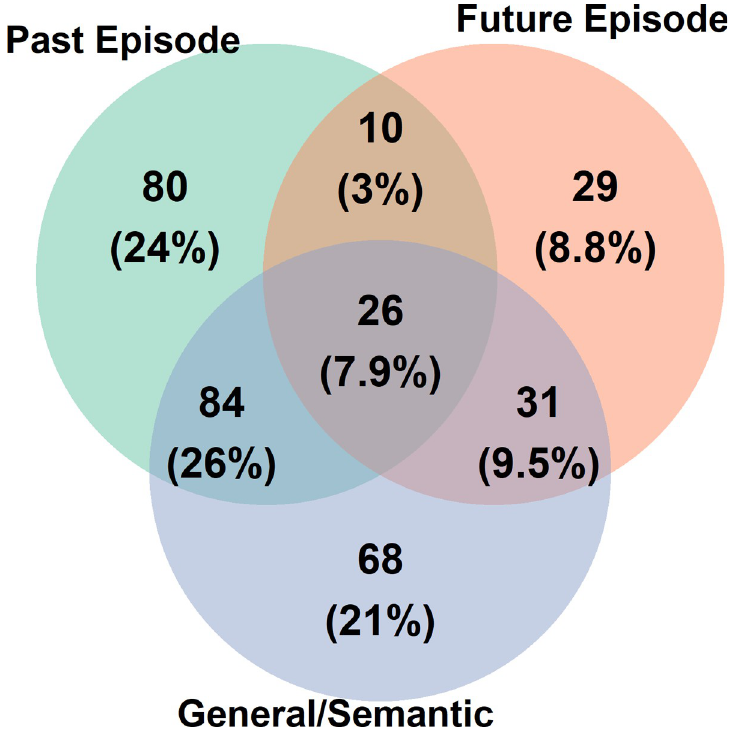
Fig 1. Co-occurrence of past and future dream sources. Data are shown as the raw number of reports identified in each category, and as a % of all dreams with a waking source identification. The “general/semantic” category collapses across reports identified as related to general categories of past experience and future concerns.